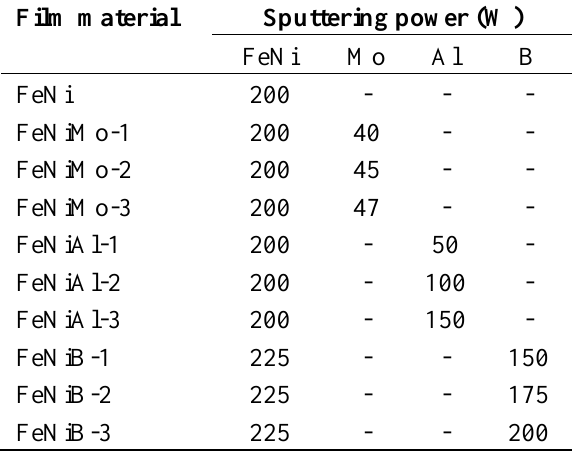
Table 1. Sputtering powers used for the deposition of thin films.